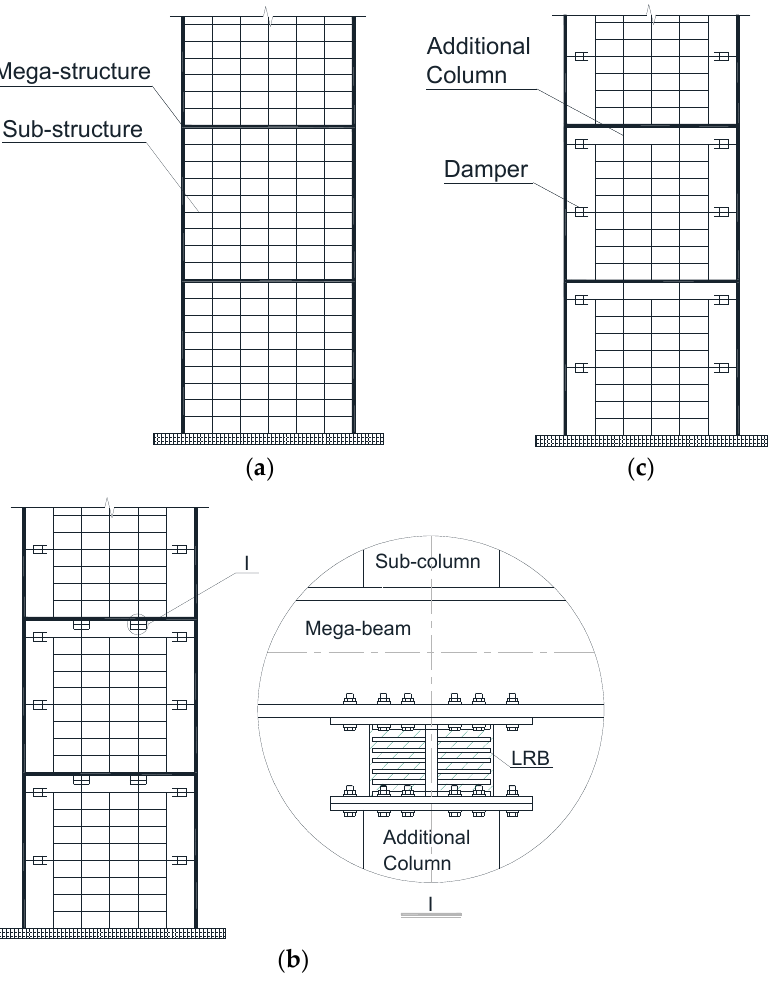
Figure 1. Different structure configurations. ( a ) MSS without seismic control devices; ( b ) MSCSS with LRBs [3]; ( c ) MSCSS without LRBs.